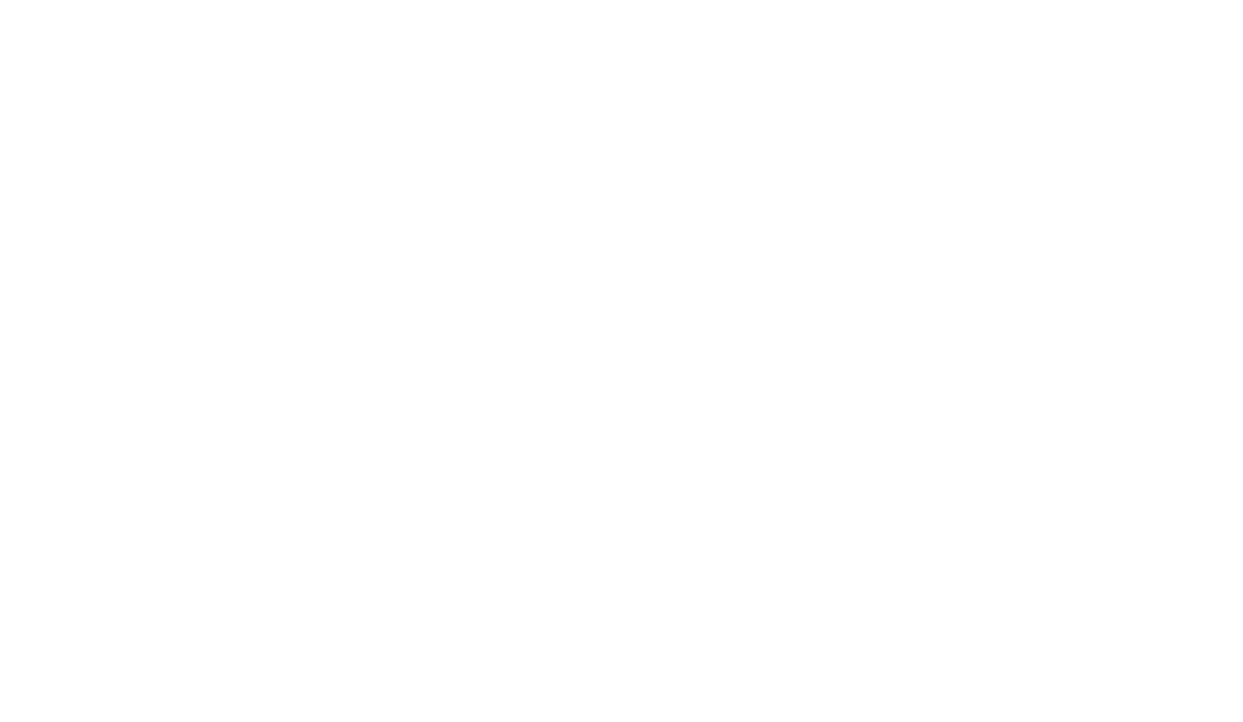
Fig. 5 Map of the general study area around the specific districts (blue and green circle) in Kuala Lumpur, Selangor, and Putrajaya,